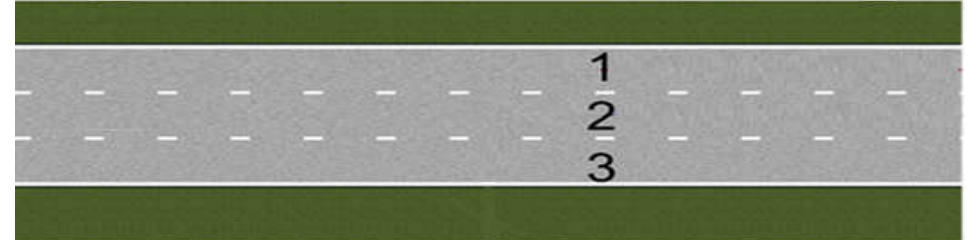
Figure 2. Scheme and layout of OMS highway infrastructure in PreScan.